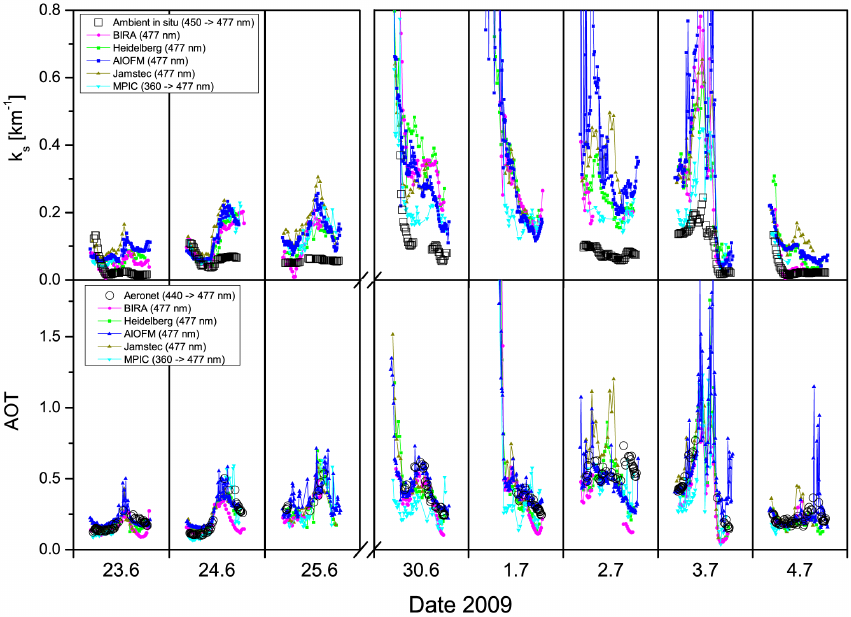
Figure 10. Time series of particle light extinction coefficient determined at the ground level (top) and AOT (bottom) from the MAX-DOAS retrieval (coloured symbols), together with the surface extinction from the humidity-controlled nephelometer (open squares) and the AOT from the sun photometer (open circles) for the golden days of the CINDI campaign. All data are converted to a wavelength of 477nm using the Ångström coefficient derived from sun photometer